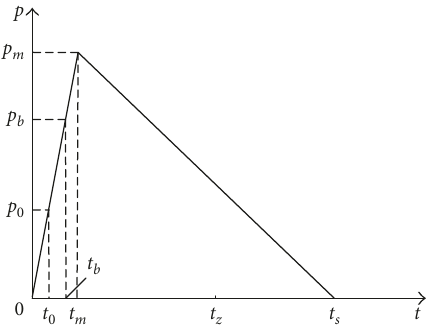
Figure 1: Triangular blast load diagram.